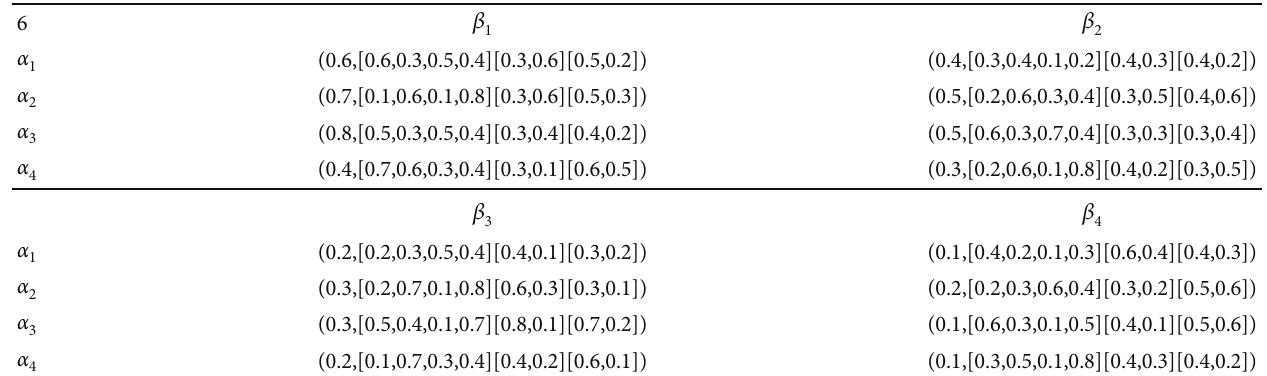
Table 6: Decision matrix of expert -6 (H 6